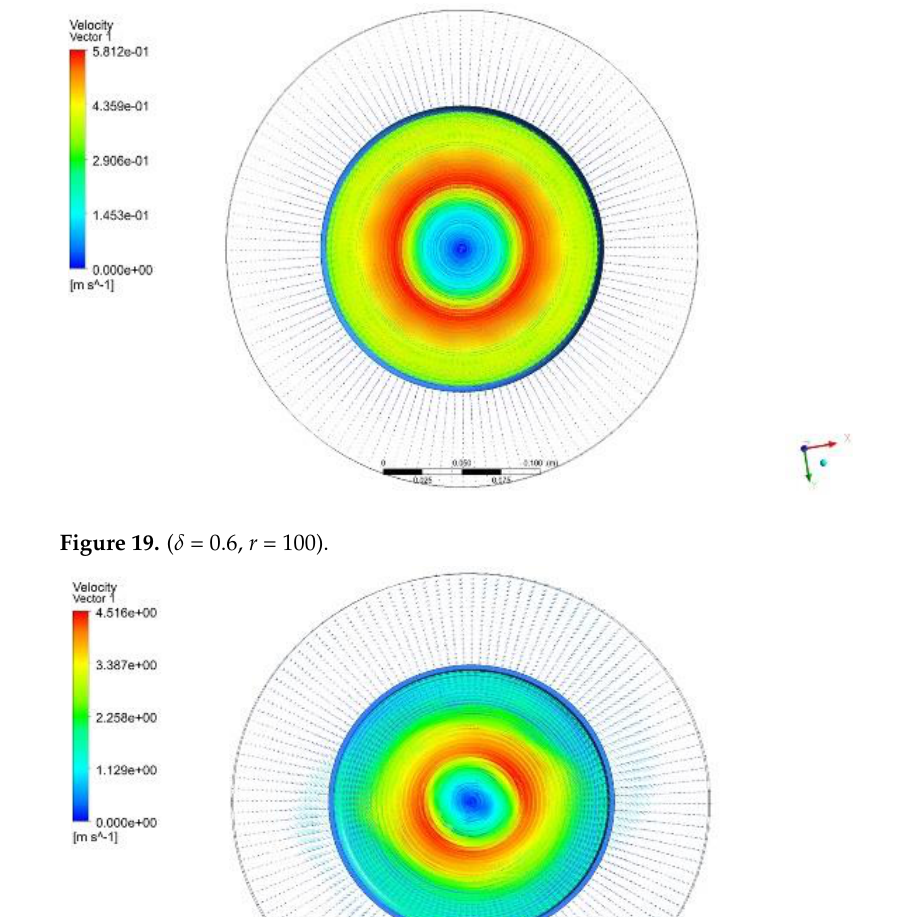
Figure 18. ( δ = 0.6, r = 1000).